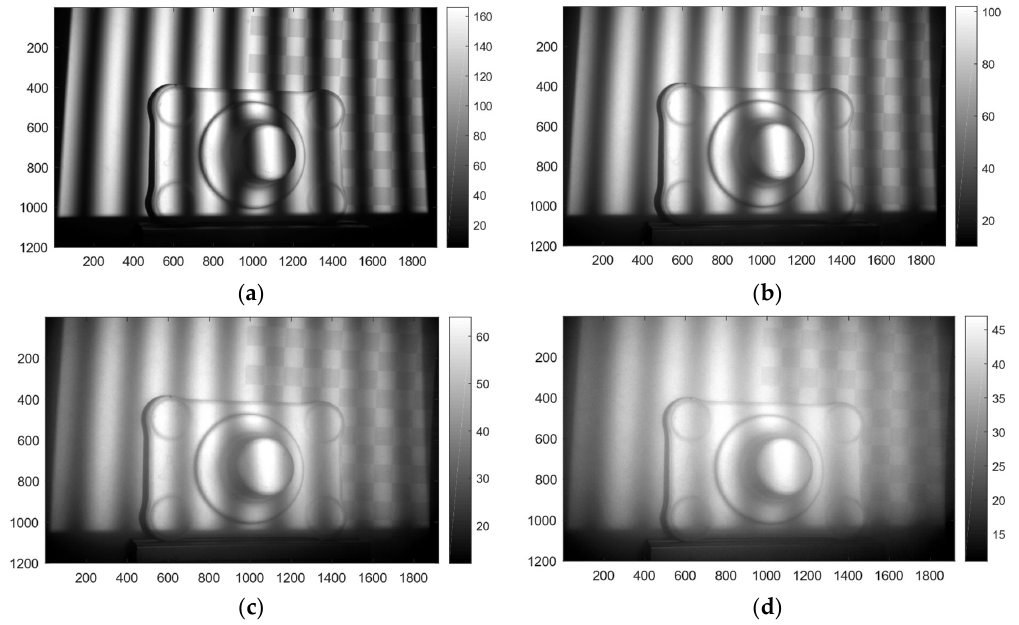
Figure 7. Images from the dataset of a sinusoid with eight periods at different turbidity levels. ( a ) Turbidity level λ (cid:2868) = 5.9 m . ( b ) Turbidity level λ (cid:2869) = 2.0 m . ( c ) Turbidity level 𝜆 (cid:2870) = 1.1 m . ( d ) Turbidity level 𝜆 (cid:2871) = 0.8 m .